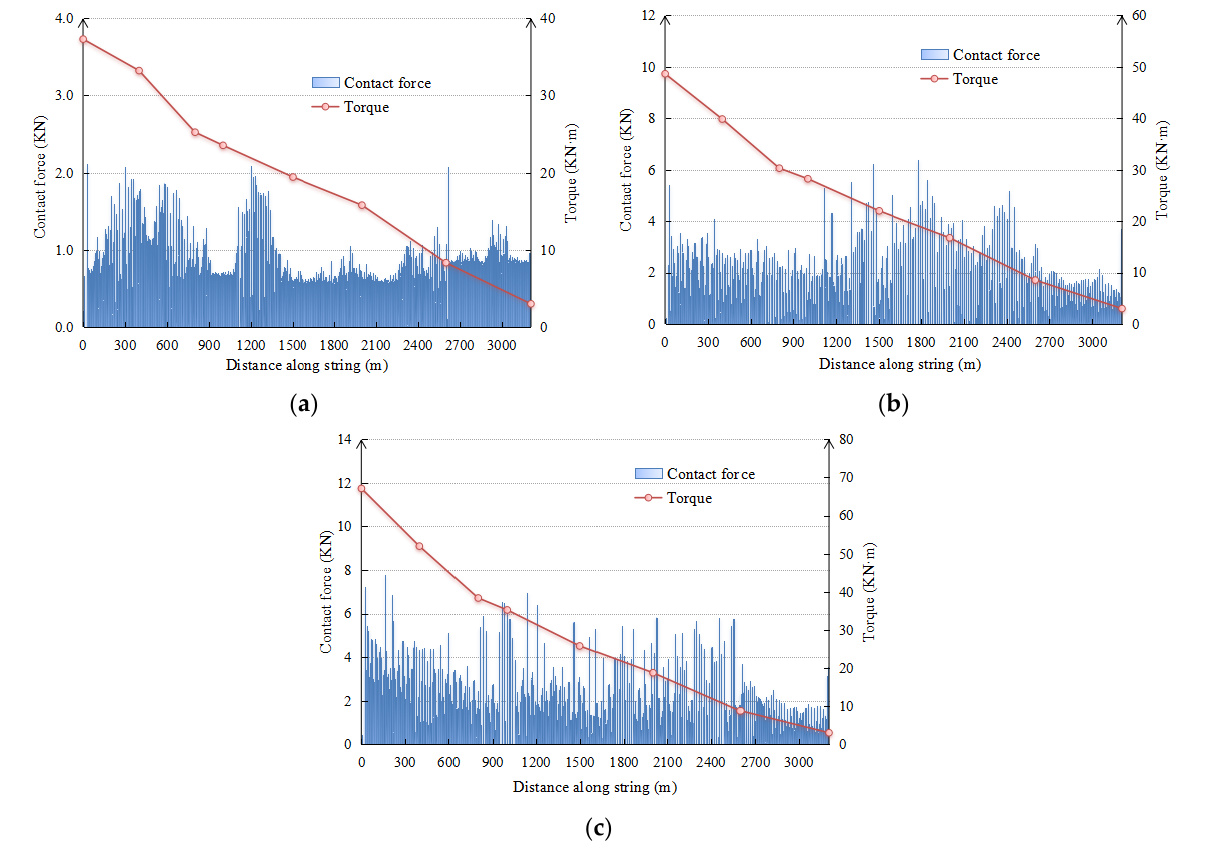
Figure 13. DS contact force and torque distribution. ( a ) 20T. ( b ) 30T. ( c ) 40T.